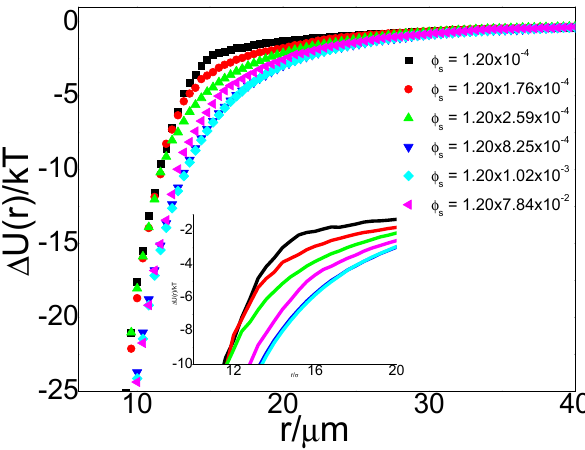
Figure 7. Effective interaction between large particles in charged interfacial systems: attraction range is longer by 20 times that of small particle sizes ( σ S = 0.21 µm), and attraction depth is larger than − 25 k B T , much longer range and stronger depth in interaction than in the uncharged system (details see Figure A2 ).